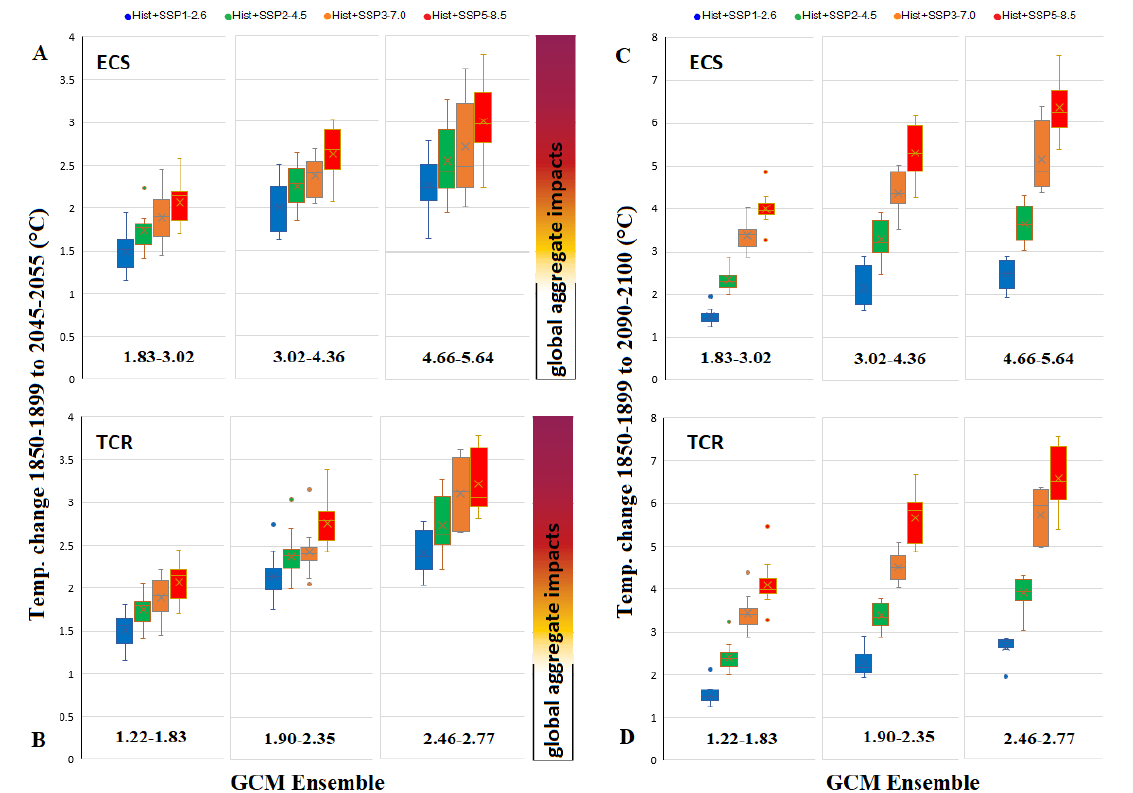
Figure 4. Temperature changes from 1850–1899 to ( A , B ) 2045–2055 and ( C , D ) 2090–2100 for the CMIP6 Global Circulation Models (GCMs) for three ECS and TCR GCM ensembles and four SSP scenarios. See also Table A5. The global aggregated impact and risk assessments assuming low to no adaptation [1]: white, undetected; yellow, moderate; red, high; violet, very